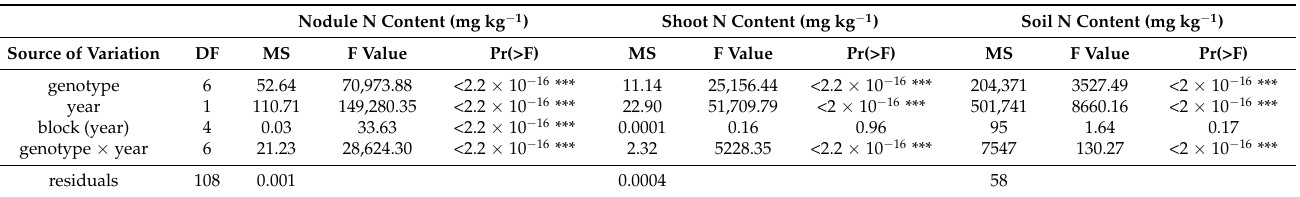
Table 3. Analysis of variance for the nitrogen acquisition of the seven chickpea genotypes grown under a low-P